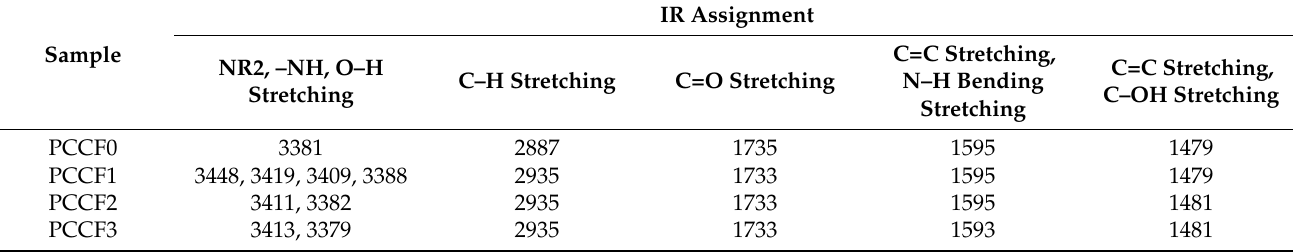
Table 2. Wavenumber and IR assignment of